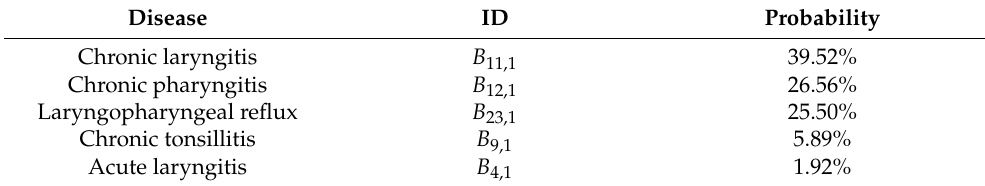
Table 2. The diagnostic result of DUCG basing on the patient’s current